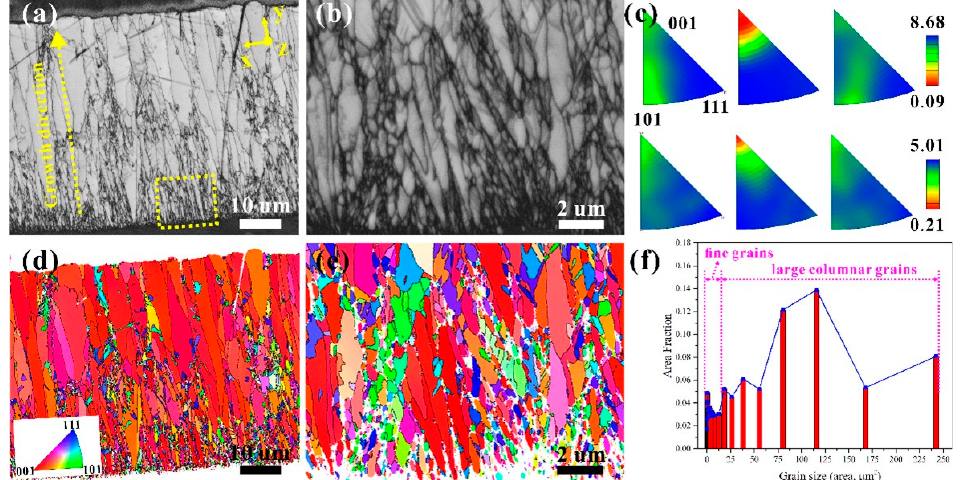
Figure 5. Band contrast maps of ( a ) whole pure Ni coating, and ( b ) local enlarged area near the substrate as marked by the yellow dotted lines in Figure 5( a ); ( d , e ) crystal orientation maps corresponding to ( a , b ); ( c ) up and down inverse pole figures corresponding to ( a , b ); ( f ) grain size distribution of the whole pure Ni coating.